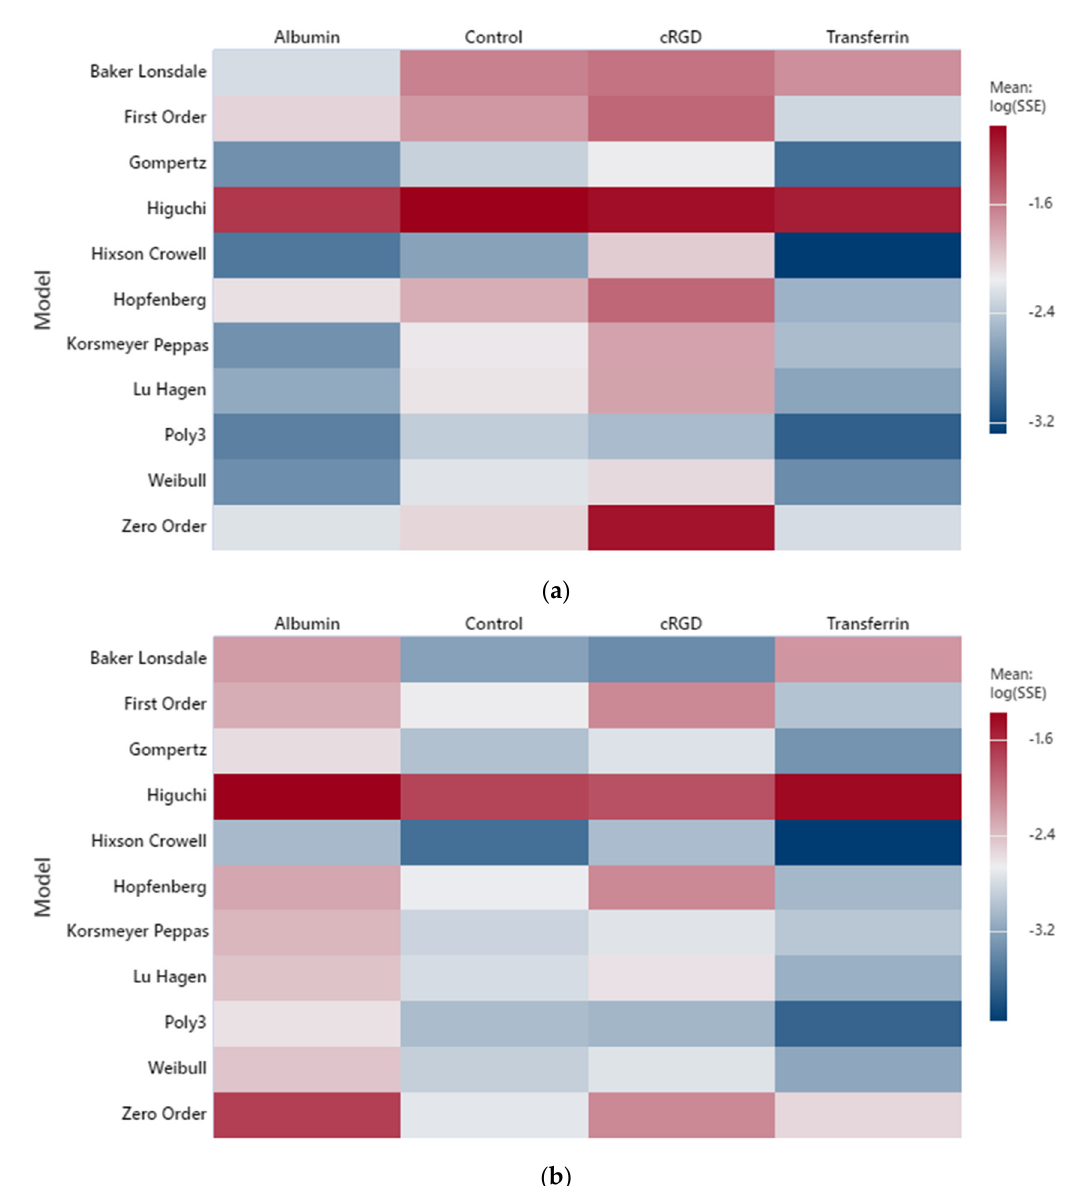
Figure 3. Heatmap for HFUS fittings at ( a ) 1.07 MHz (10.5 W/cm 2 ) and ( b ) 3.00 MHz (173 W/cm 2 ).